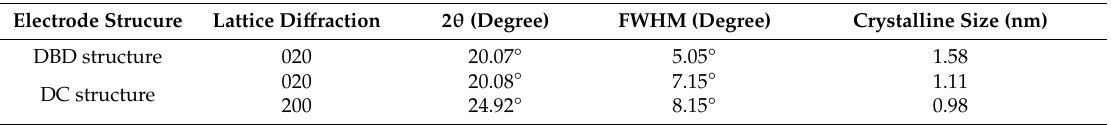
Figure 8. XRD patterns of PANI synthesized in two different discharge electrode structures, such as ( a ) proposed DBD and ( b ) previous DC structures. Table 2. Full width at half maximum (FWHM), crystalline size of PANI nanoparticle powders synthesized in two different discharge structures, DBD and DC structures.